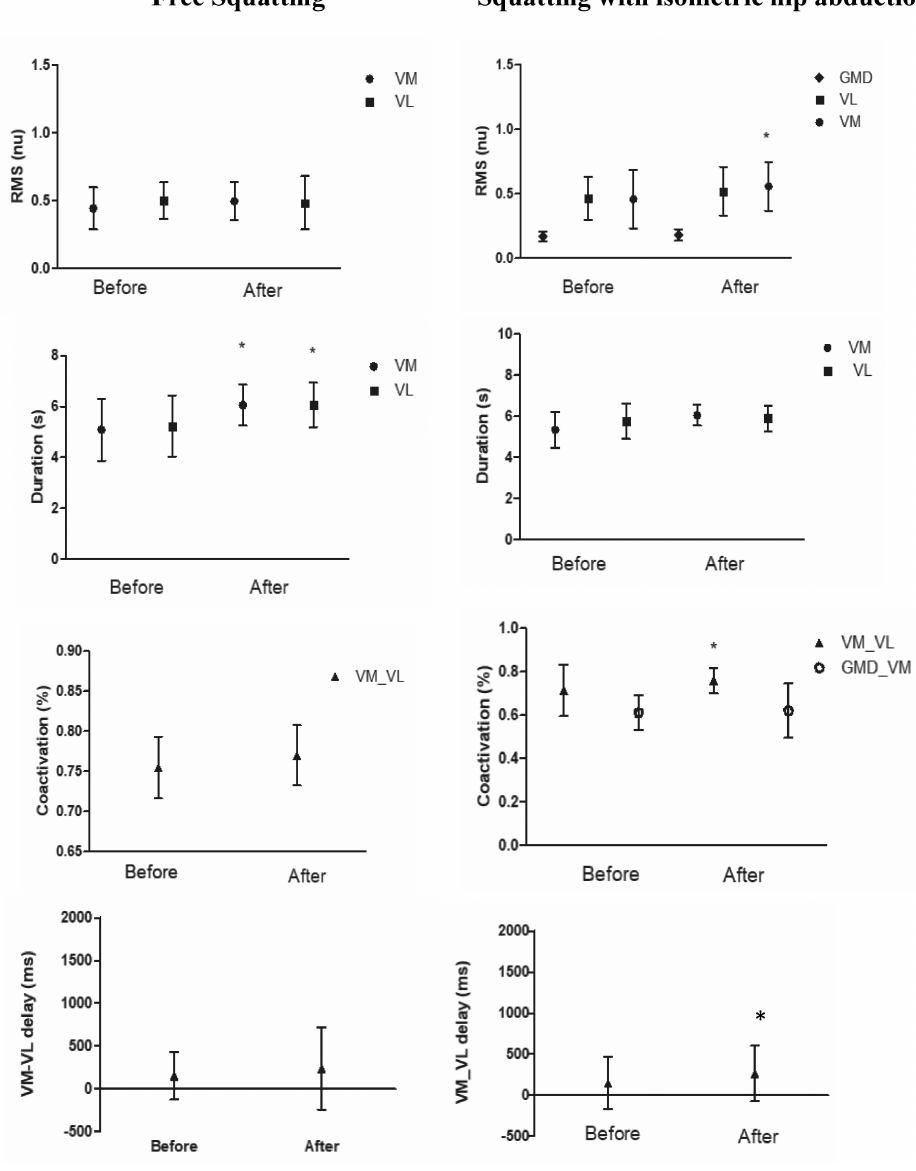
Figure 3 - Graphs representative of the RMS (nu - normalized unit), signal duration (s - seconds), muscular coactivation (%) and VM-VL delay (ms - milliseconds) of the vastus medialis (VM), vastus lateralis (VL) and gluteus medius (GMD), before and after the application of the intervention pro- tocol. *indicates statistically significant difference (p < 0.05).